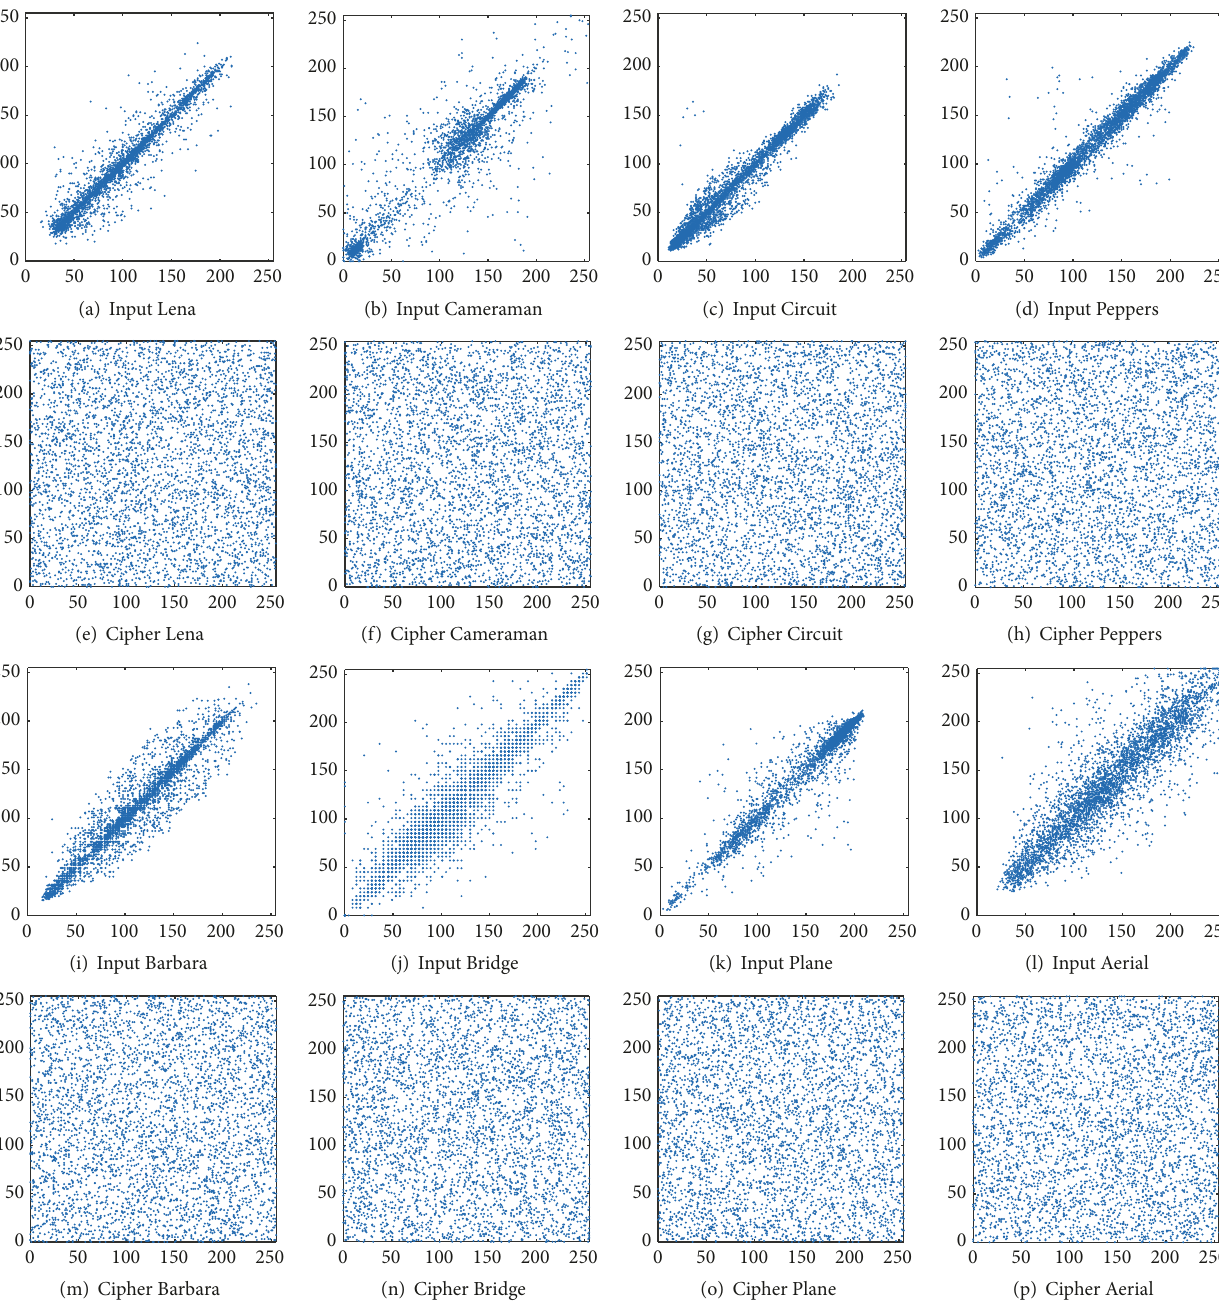
Figure 5: The adjacent-pixel distribution maps of the input images and the corresponding cipher images in horizontal direction.